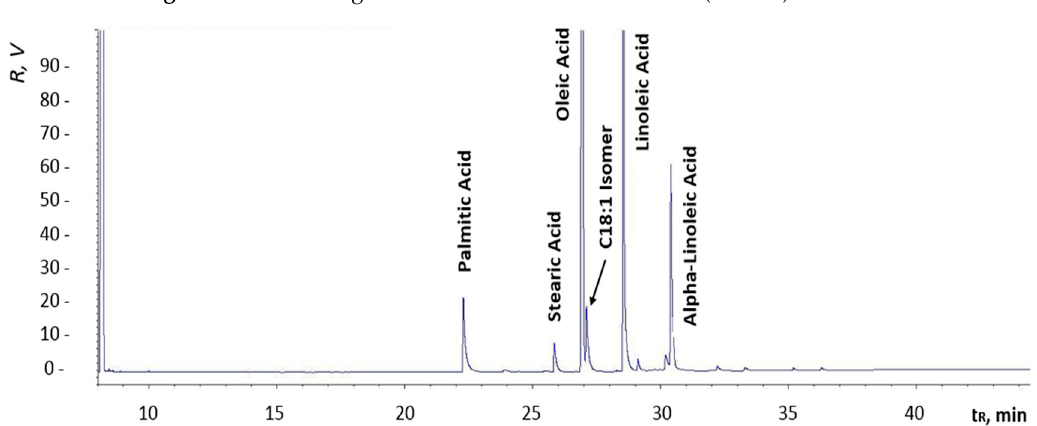
Figure 14. Chromatogram of 100% FAME with identified main components (methyl esters).